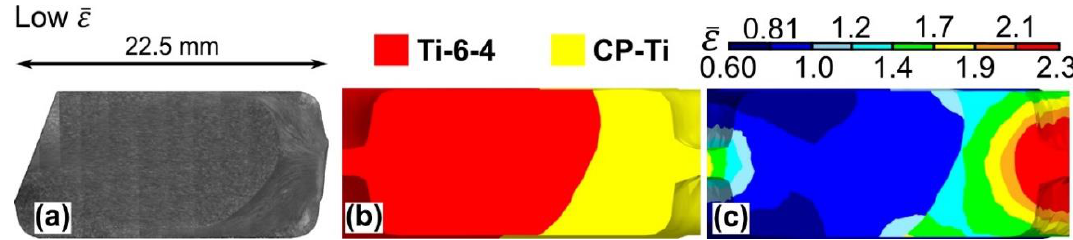
Figure 13. ( a ) Photograph of the low strain cross-section of the eye-bolt 1 forging (Ti-6-4 and CP-Ti) from Figure 10b; ( b ) corresponding simulation showing the alloy distribution; and ( c ) the corresponding simulation showing the e ff ective strain distribution. Approximate forging temperature between 860 and 878 ◦ C, with a total of nine hammer